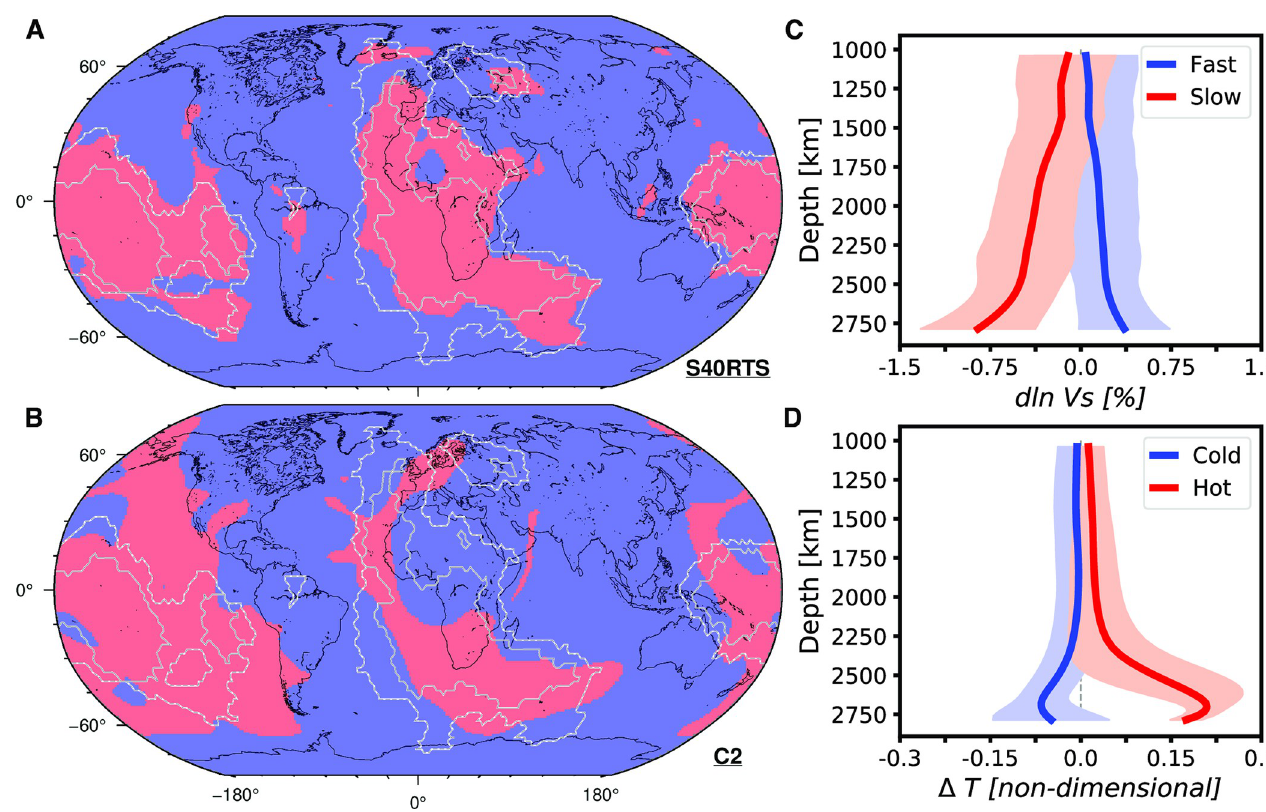
Fig 3. Cluster analysis of tomographic and mantle flow models. A, B/ spatial distribution of two lower mantle regions revealed by k-means cluster analysis between 1,000 km and 2,800 km depths for A/ tomographic model S40RTS [61] and B/ mantle flow model Case 2. Coastlines are shown in black, and the grey lines indicate a value of five (solid) and a value of one (dashed) in a vote map of low-velocity regions from five S-wave tomographic models [66]. These figure panels were created with GMT6 [47] and the Global Self-consistent, Hierarchical, High-resolution Geography Database (GSHHG) coastlines are republished from [48] under a CC BY license, with permission from Paul Wessel, original copyright 1996. C, D/ depth profiles of clustered properties in each cluster: C/ velocity profiles in high-velocity (fast, in blue) and low-velocity (slow, in red) regions for S40RTS and D/ temperature profiles in low-temperature (cold, in blue) and high-temperature (hot, in red) regions for Case 2. The solid curves are the mean, and the transparent envelopes are the associated standard deviation. None of the data in this figure are